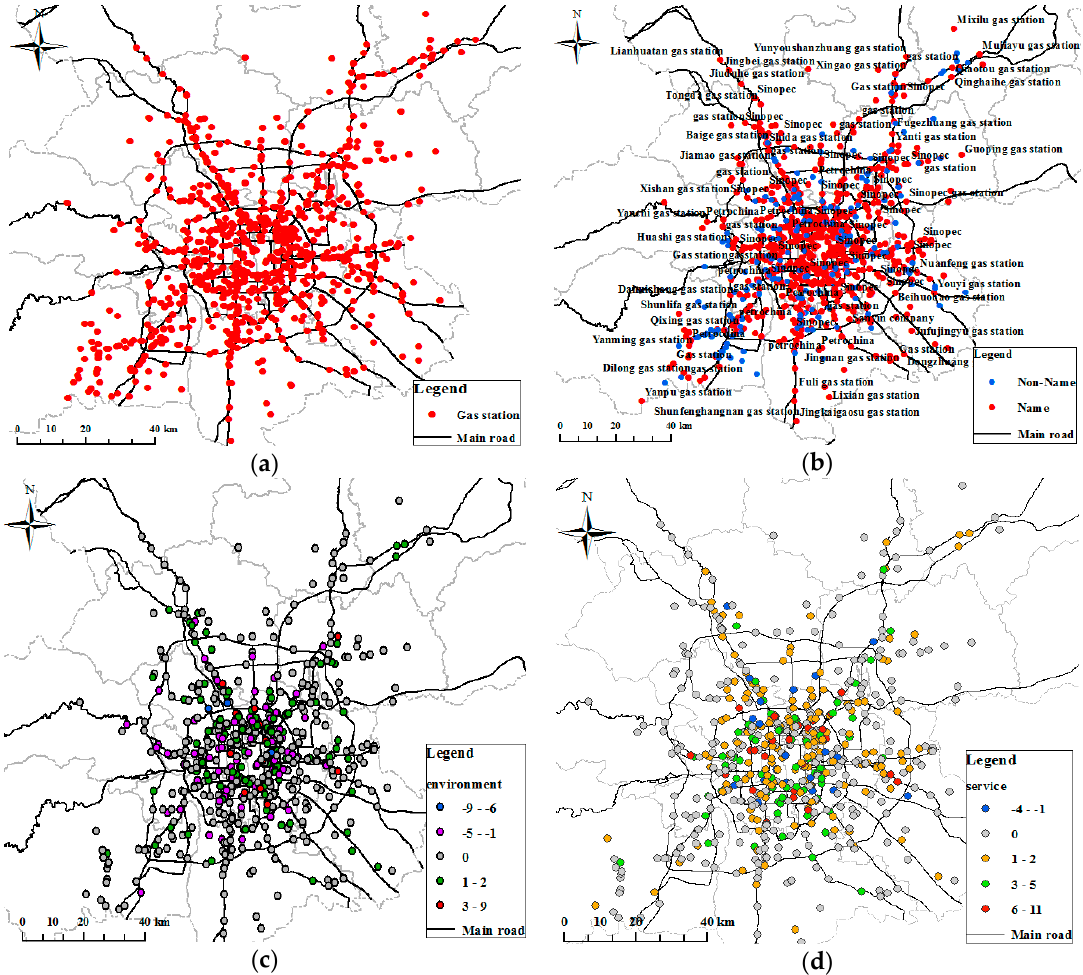
Figure 11. Final gas station POI point map. ( a ) The overall results after fusion; ( b ) Attribute information of gas station after fusion; ( c ) Classification gas station by environment score (only for POIs with score information); ( d ) Classification gas station by service score.